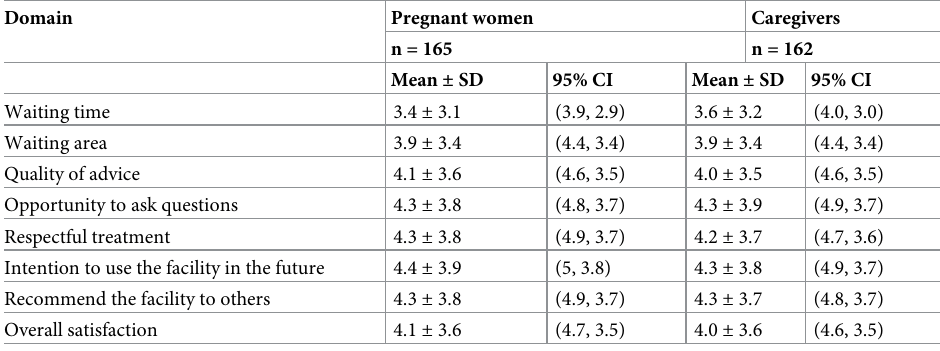
Table 6. Satisfaction with nutrition services among of pregnant women and caregivers of young children.